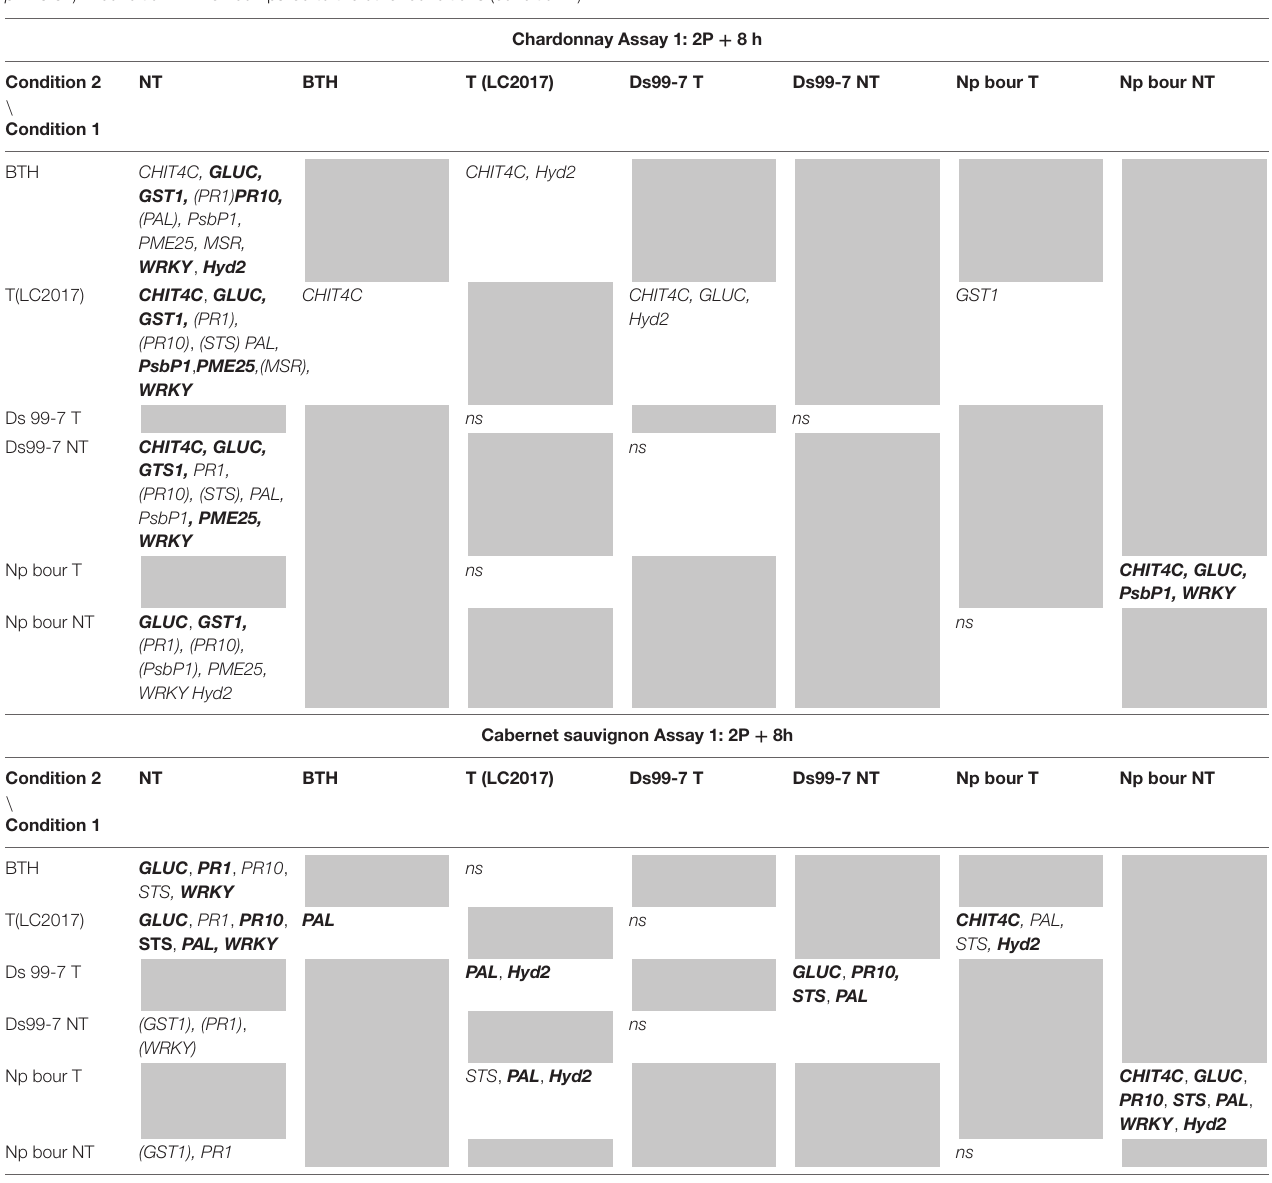
TABLE 1 | Results of the statistical analysis (Mann-Whitney U test) on Assay 1 transcriptomic data recorded in vines “Chardonnay” (upper part) and “Cabernet sauvignon” (lower part) at 2P + 8 h: the reported genes resulted with both relative expression > 2 and significantly induced for p < 0.05 (in bold those significant for p < 0.01) in condition 1 when compared to the other conditions (condition